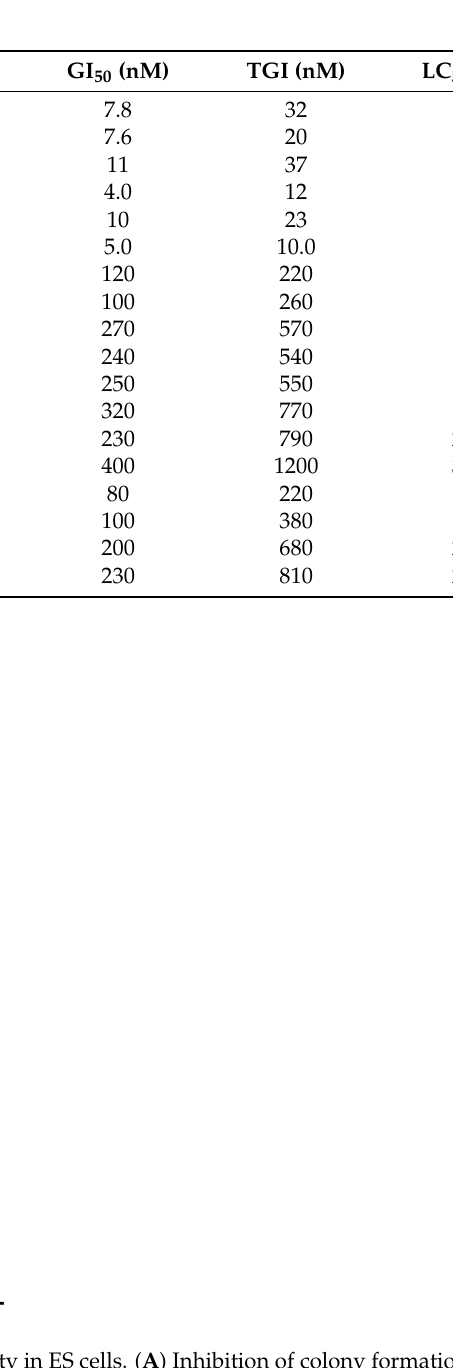
Figure 3. Altertoxin II has persistent activity in ES cells. ( A ) Inhibition of colony formation by ATXII after drug washout. A-673 cells were treated with ATXII for 4 h, the drug was washed out, and the cells were allowed to form colonies for 14 days. ( B ) Quantification of colony number after treatment with ATXII at the indicated concentration for 4 h followed by drug washout. n = 3; *** p ≤ 0.001, **** p ≤ 0.0001 compared to vehicle; one-way ANOVA with Tukey’s post-hoc